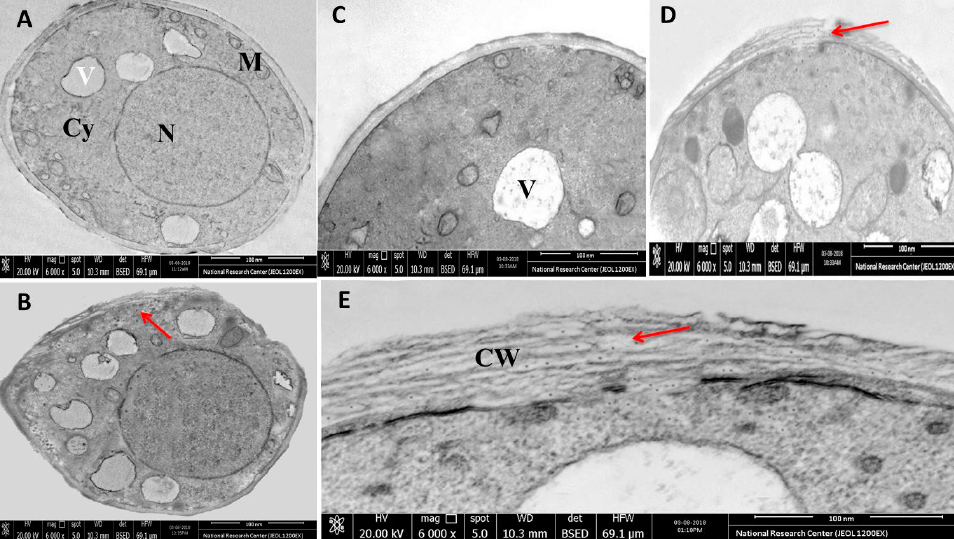
Figure 6. Ultra structural images obtained by TEM of ( A , C ) untreated and ( B , D , E ) rGO CuO NP-treated FORL cells. ( E ) Magnified view for treated fungal cell wall layers showing the internalization of NPs and their distribution. Red arrows point successful penetration of the rGO-CuO NPs in the fungal cells.